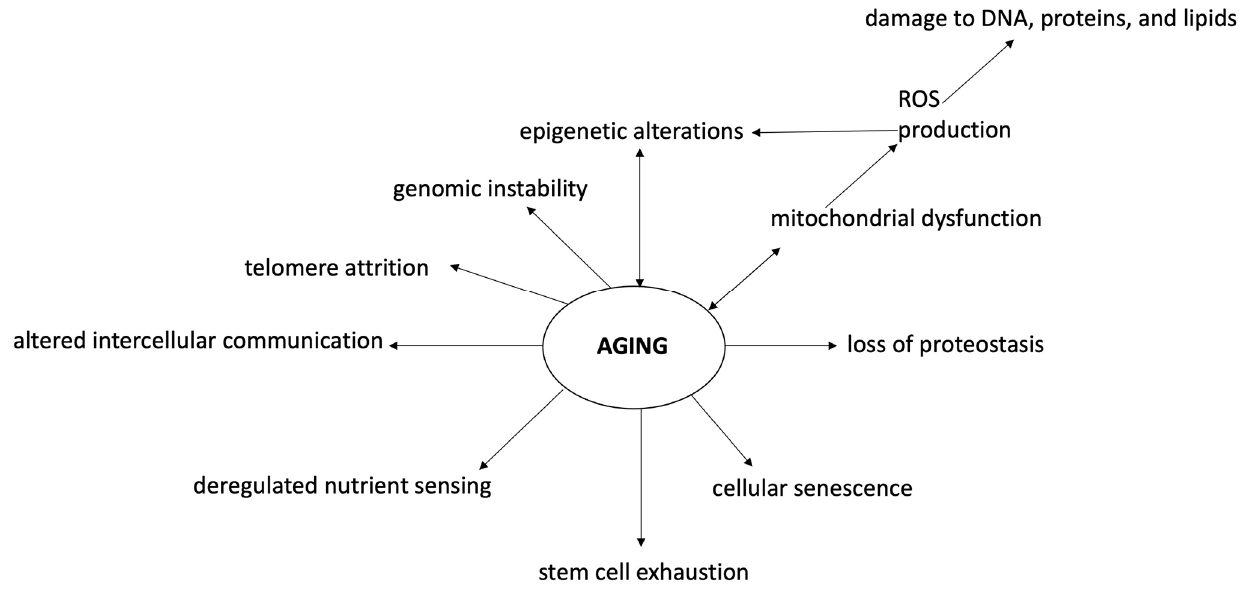
Figure 2. Oxidative stress and epigenetic changes in the cognitive aging process. Aging and neurodegenerative diseases are associated with cognitive, emotional, and social deficiencies mostly linked to brain alterations. Aging is characterized by a state of genomic instability, telomere attrition, epigenetic alterations, loss of proteostasis, mitochondrial dysfunction, cellular senescence, deregulated nutrient sensing, stem cell exhaustion, and altered intercellular communication. In this context, oxidative stress and epigenetic modifications play a major role, both as perpetrators and consequences of aging processes. Oxidative stress and ROS increase cause DNA and macromolecule damage associated with mitochondrial dysfunction, inflammation reaction, apoptosis, and epigenetic modifications. Epigenetic changes are associated with DNA hypomethylation, promoter hypermethylation, and altered histone modification due to various mechanisms (including oxidative stress). In this context, antioxidants may play a major role in preventing cognitive aging problems. ROS—reactive oxygen species.